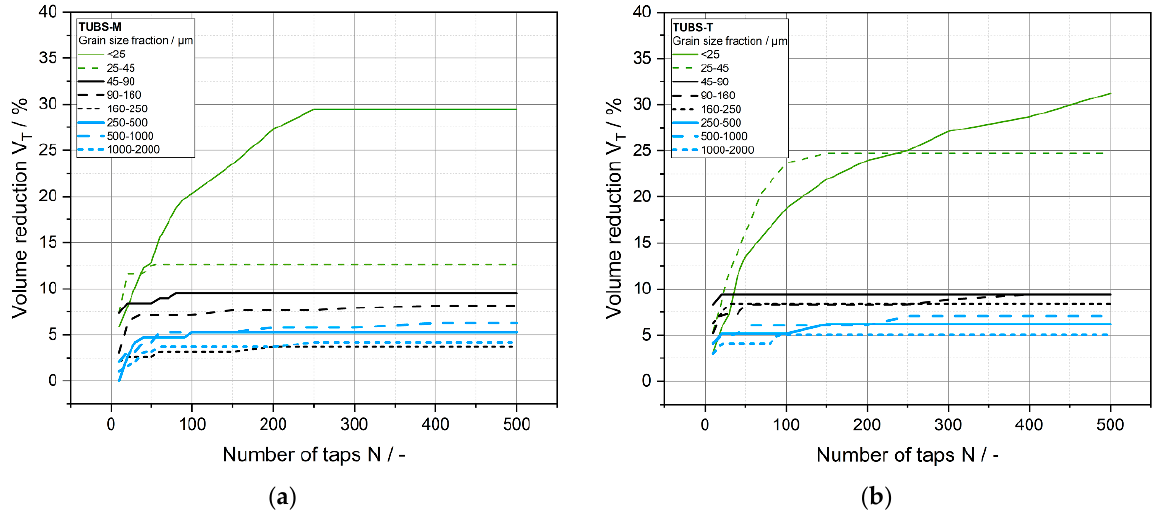
Figure 7. Volume reduction of the grain size fractions of TUBS-M ( a ) and TUBS-T ( b ) as a function of the number of taps.